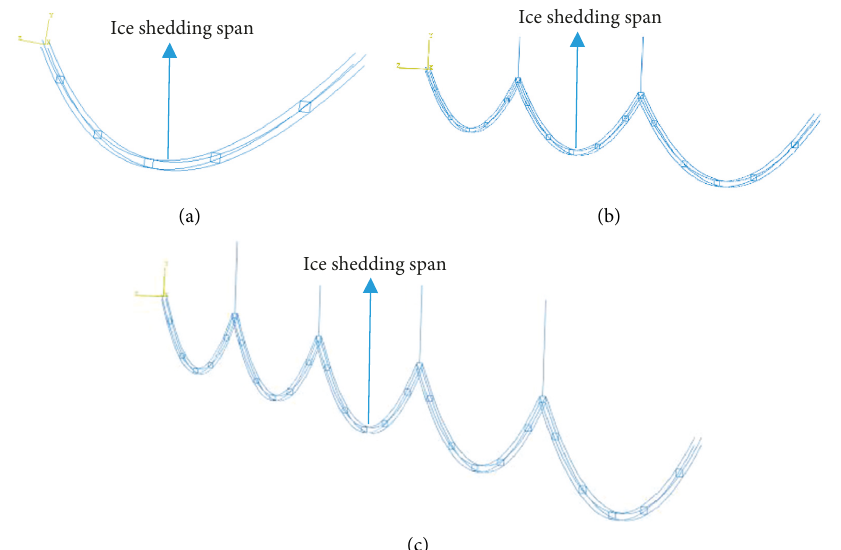
Figure 14: Finite element model of quad bundle conductors with multispan: (a) Single-span, (b) Three-span, (c)